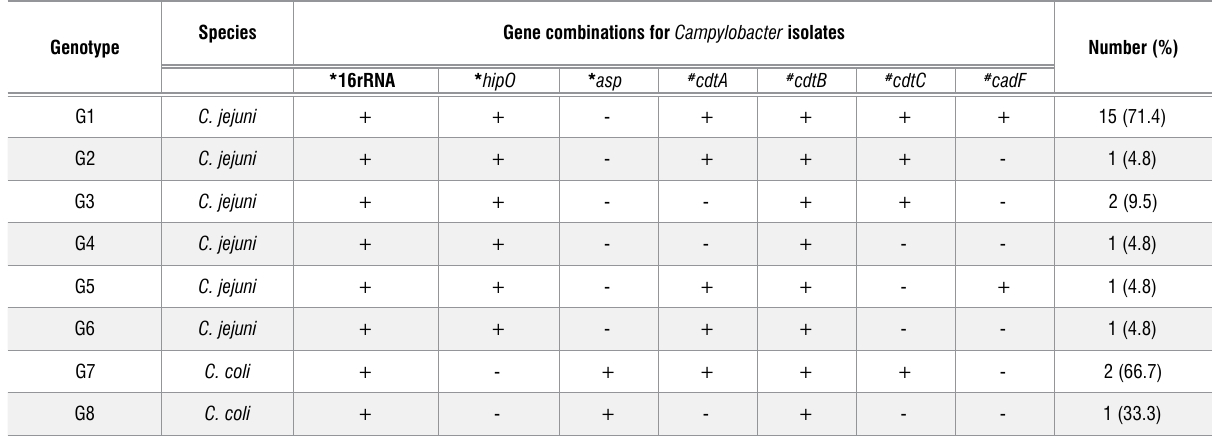
Proportion of different genotypes of Campylobacter isolates. Genotyping was based on the various combinations of identification (*) and virulence ( # ) genes. Species Gene combinations for Campylobacter Genotype